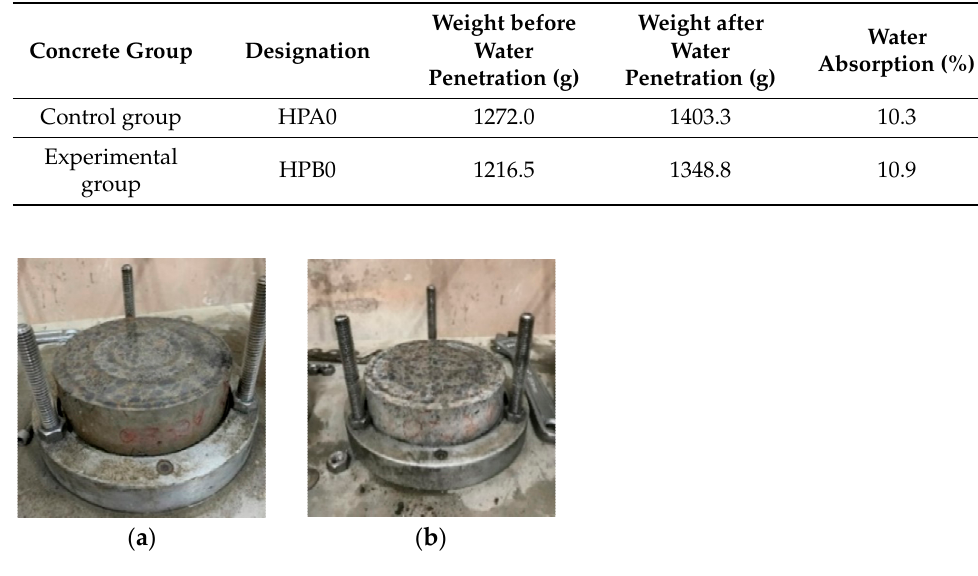
Figure 26. Appearance of the surface of the specimens exposed to high temperature after the water- penetration test: ( a ) control group; ( b ) experimental group. Table 27. Penetration test results of the concrete after exposure to high temperature.